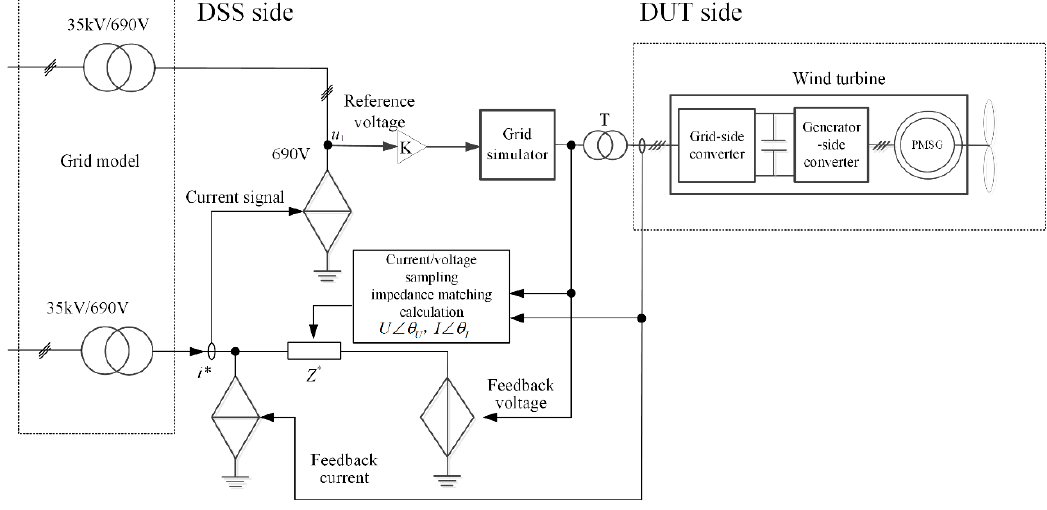
Figure 9. Simulation model of RTISS. Table 2. Impedance parameters of Grid model.